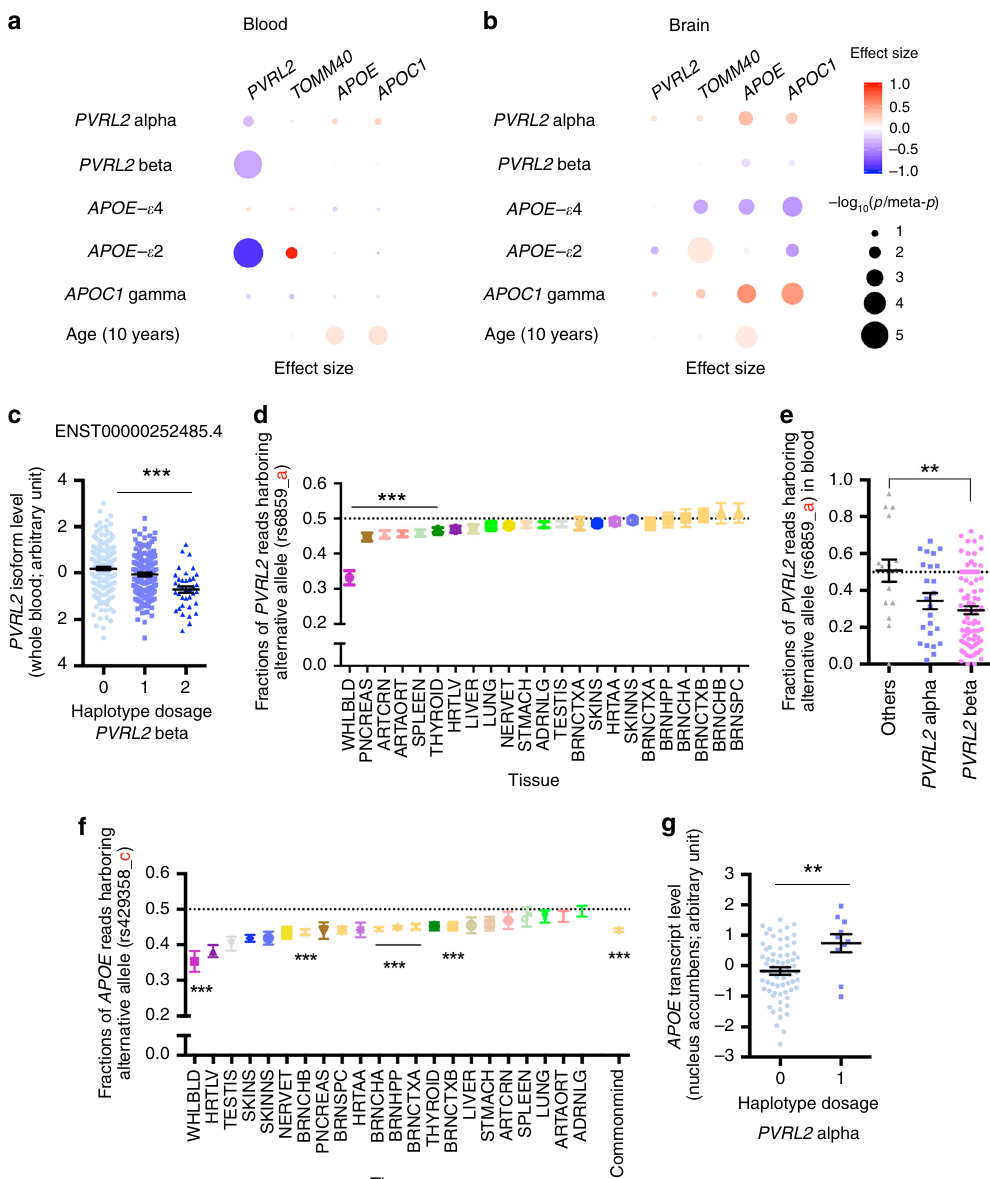
Fig. 5 Modulatory effects of AD-associated haplotypes in APOE and the surrounding region on the expression of nearby genes. a , b Dot plots showing the haplotype – expression association results of the AD-associated haplotypes in PVRL2 , APOE , and APOC1 and their nearby genes in ( a ) blood and ( b ) the brain. Dot color and size represent effect size and signi fi cance level ( p or meta- p values), respectively. c Association between PVRL2 beta haplotype with transcript level of blood PVRL2 isoform (ENST00000252485.4) ( n = 365, T = − 5.470, *** p < 0.001, Beta = − 0.449). d Allelic imbalance of PVRL2 variant rs6859 across multiple tissues. One-sample t -test (*** p < 0.001). Data were obtained from the GTEx dataset. e Association between PVRL2 minor haplotypes and transcripts of PVRL2 with variant rs6859 in blood ( n = 124, T = − 3.218, ** p < 0.01, Beta = − 0.209, for beta haplotype against the major haplotype). f Allelic imbalance of APOE variant rs429358 across multiple tissues. One-sample t -test (*** p < 0.001 for representative results). Data were obtained from the GTEx and CommonMind datasets. g PVRL2 haplotype alpha was associated with changes of brain APOE transcript level in individuals not carrying an APOE- ε 4 allele (nucleus accumbens, n = 67 or 10 for non- APOE- ε 4 carrying individuals harboring 0 or 1 copies of PVRL2 haplotype alpha, respectively; T = 2.963, ** p < 0.01, Beta = 0.943, for alpha haplotype against the major haplotype). Data are plotted as mean ± SEM in c , e , and g . Tissue abbreviations: ADRNLG adrenal gland, ARTAORT artery-aorta, ARTCRN artery-coronary, BRNCHA brain-cerebellum, BRNCHB brain-cerebellar hemisphere, BRNCTXA brain-cortex, BRNCTXB brain-frontal cortex (BA9), BRNHPP brain-hippocampus, BRNSPC brain-spinal cord (cervical c-1), HRTAA heart-atrial appendage, HRTLV heart-left ventricle, LIVER liver, LUNG lung, NERVET nerve-tibial, PNCREAS pancreas, SKINNS skin-not sun exposed (Suprapubic), SKINS skin-sun exposed (Lower leg); SPLEEN spleen, STMACH stomach, TESTIS testis, THYROID thyroid, UTERUS uterus, WHLBLD whole